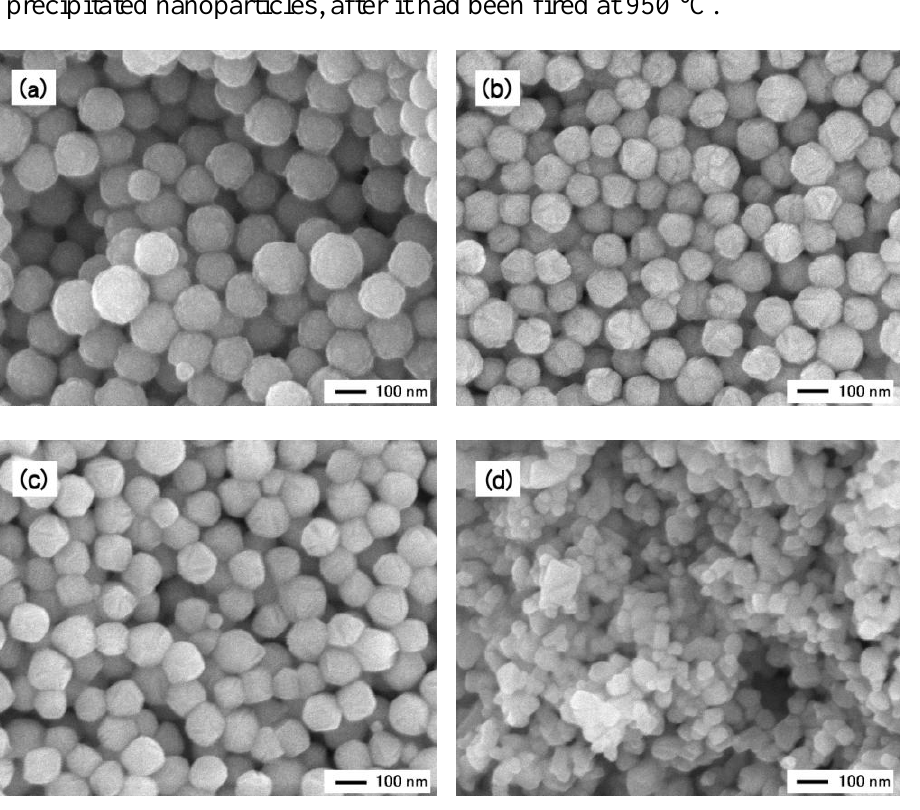
Figure 1. SEM images of the cerium oxide nanoparticles and thick films used in this study. ( a ) the as-prepared cerium oxide nanoparticles, ( b ) a thick film prepared from the core-shell nanoparticles, after it had been fired at 900 °C, ( c ) a thick film prepared from the core-shell nanoparticles, after it had been fired at 1,000 °C, and ( d ) a thick film prepared from the precipitated nanoparticles, after it had been fired at 950